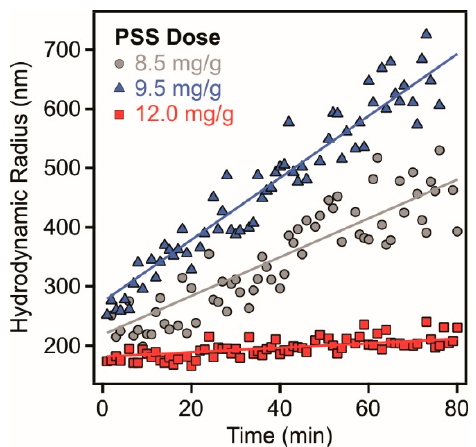
Figure 3. Hydrodynamic radii of LDH particles as a function of the measurement time in the presence of 8.5 mg/g (triangles), 9.5 mg/g (circles) and 12.0 mg/g (squares) PSS. The solid lines are linear fits used to calculate the apparent rates according to Equation (3).